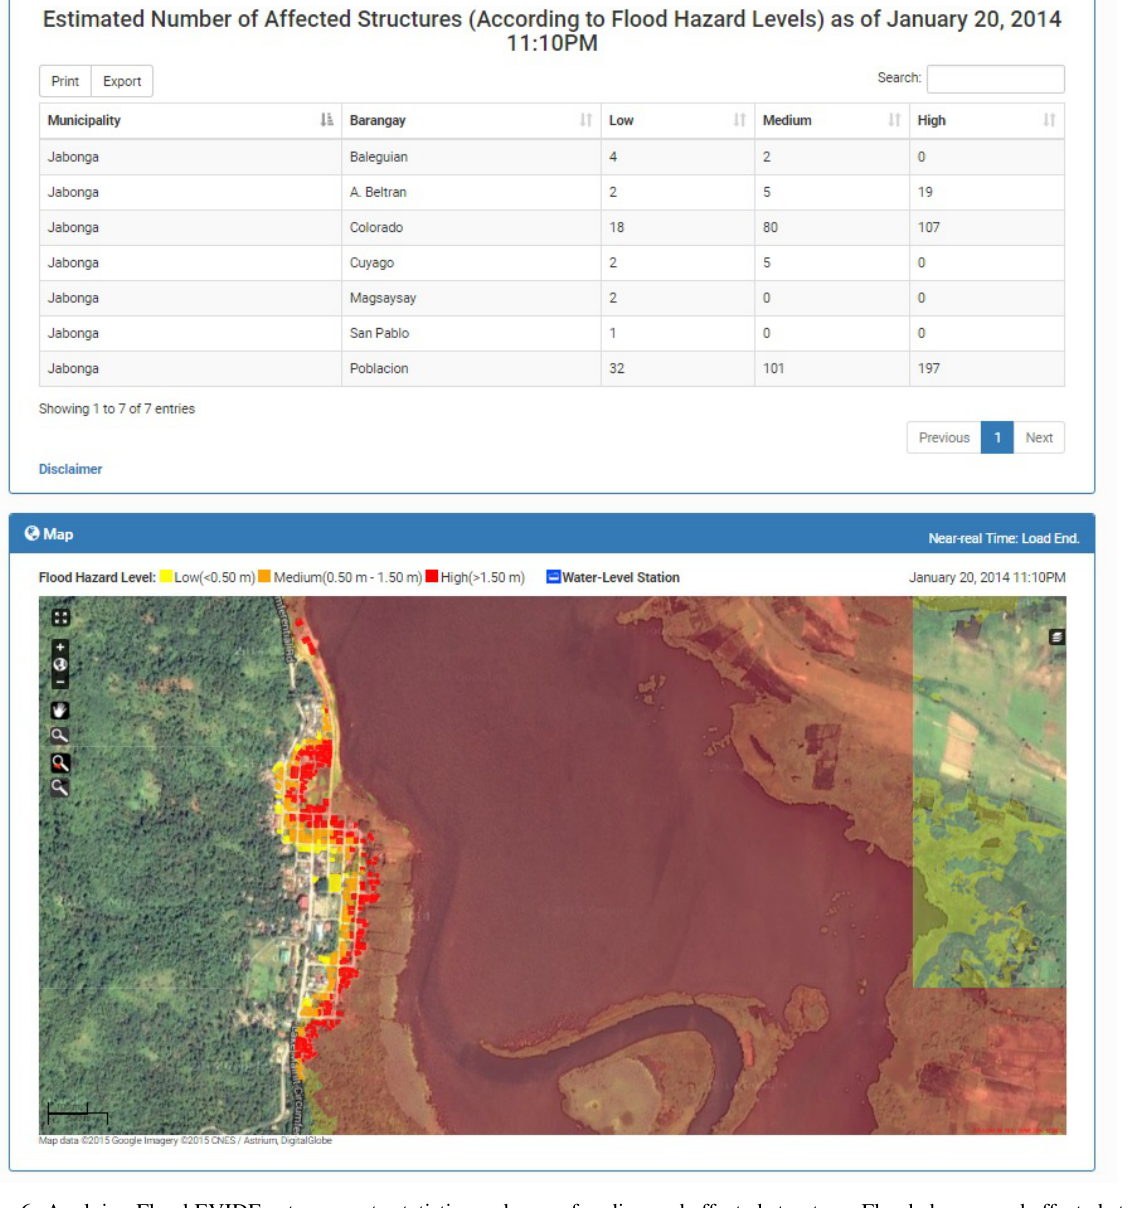
Figure 6: Applying Flood EVIDEns to generate statistics and map of ooding and affected structures.Flooded areas and affected struc- tures are color-coded according to hazard level (yellow: low; orange: medium; red: